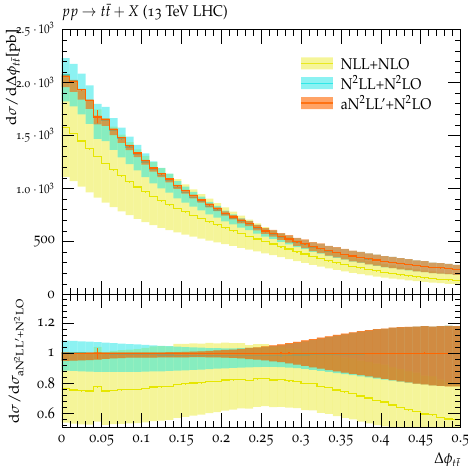
Figure 9 . The resummation improved azimuthal spectra d σ and approximate N 2 LL 0 +N 2 LO accuracies (aN 2 LL 0 +N 2